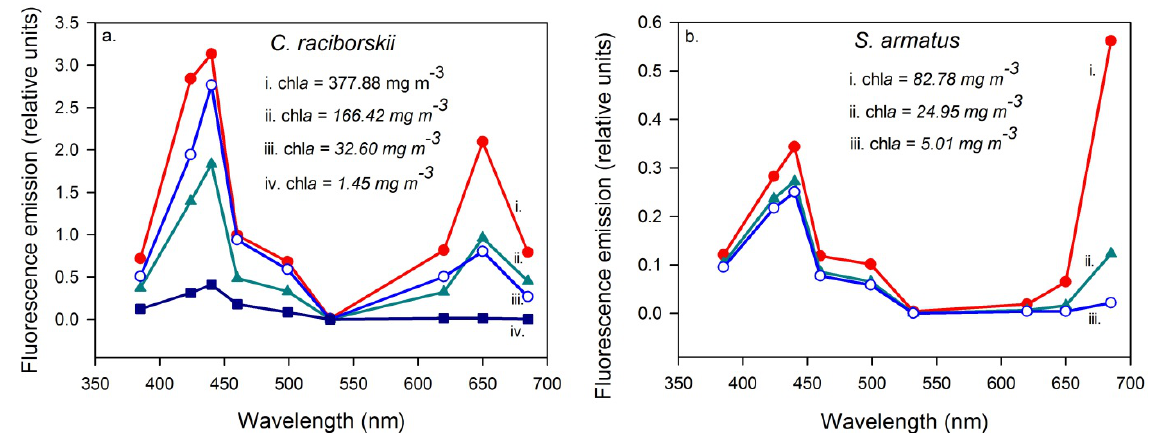
Figure 5. UFL fluorescence emission spectra (excitation laser pulse wavelength = 355 nm) for ( a ) Cylindrospermopsis raciborskii and ( b ) Scenedesmus armatus cultures of varying biomass